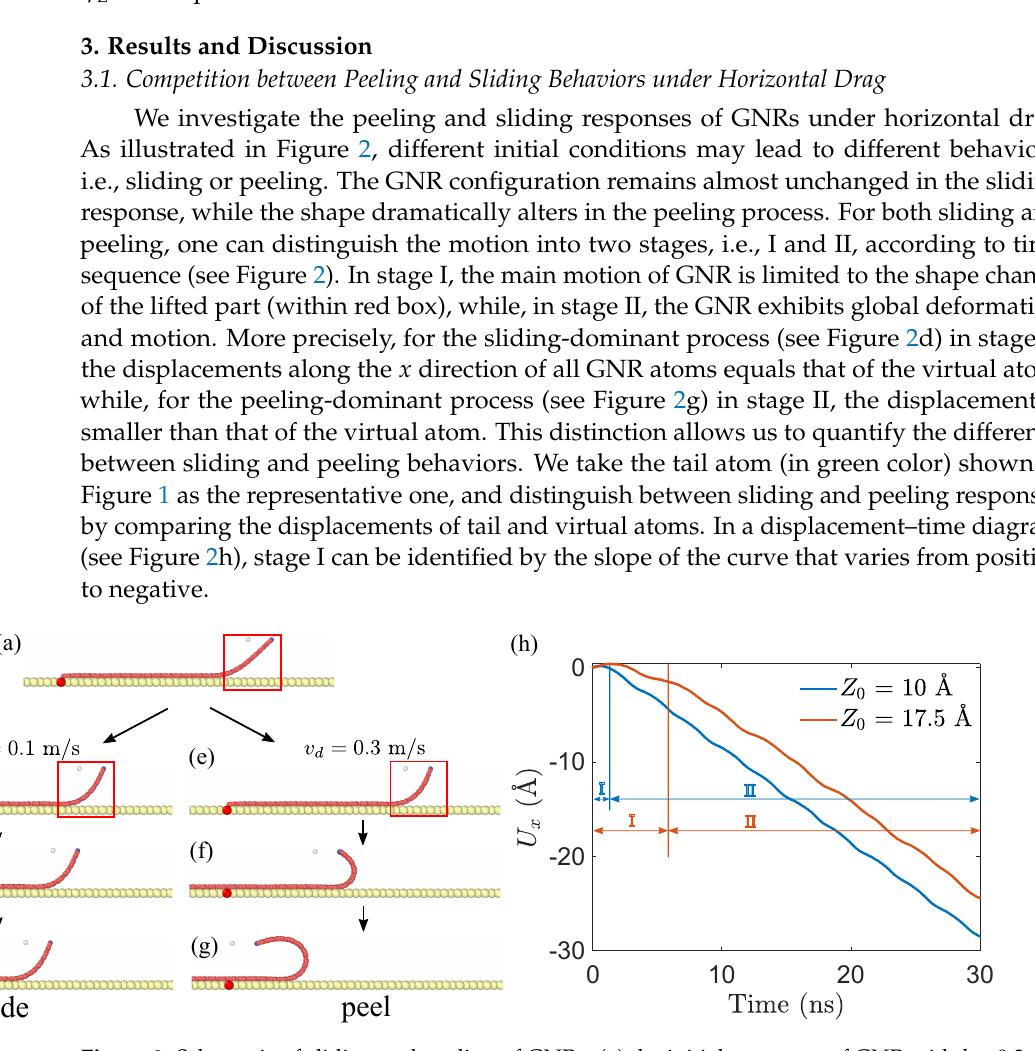
Figure 2. Schematic of sliding and peeling of GNRs. ( a ) the initial geometry of GNR with l x ∼ 9.2 nm and lifting height Z 0 = 15 Å before dragging. The red atom in the substrate refers to a reference point. ( b – d ) show the sliding-dominant process when v d = 0.1 m/s, while ( e – g ) demonstrate the peeling-prevailing progress when v d = 0.3 m/s. The motion of GNRs can be distinguished into two stages: in stage I, the main movement is constrained to the lifted part (within red box), while, in stage II, the motion involves both sliding and peeling. ( h ) shows the displacement–time diagram of GNRs with l x ∼ 11.3 nm, v d = 0.1 m/s and Z 0 = 10, 17.5